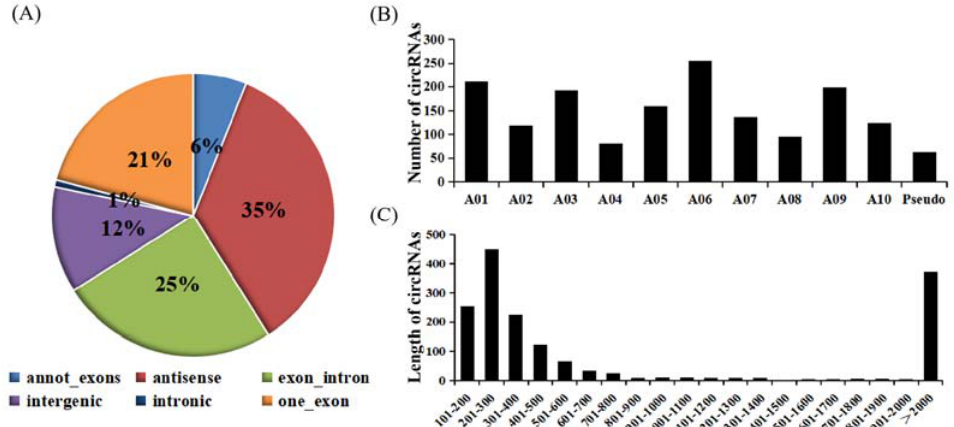
Figure 1. Characterization of circRNAs identified between control plants and plants infected with the two pathotypes of P.brassicae at 8 and 23 dpi. ( A ) Types of circRNAs. ( B ) Histogram of the distribution of circRNAs on the chromosome. ( C ) Distribution of the length of the circRNAs. To validate the circular RNAs detected from RNA sequencing, several circRNAs were randomly selected for polymerase chain reaction amplification. A pair of convergent primers was designed to amplify the linear DNA fragments when cDNA or genomic DNA